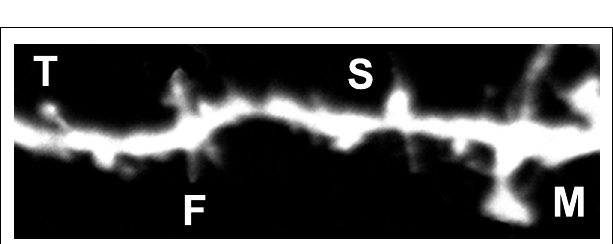
FIGURE 4 | Representative image of DiI labeled spines. Filopodia-like (F), long-thin (T), stubby (S), and mushroom (M) spines are identified based on structural measures.